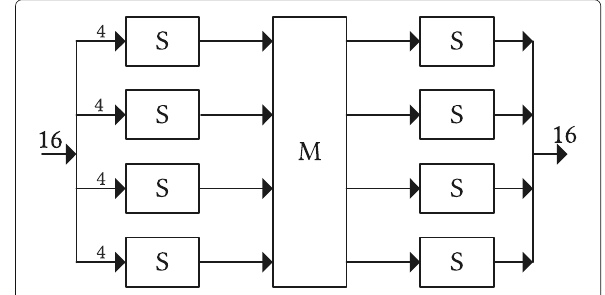
and X 2 ← X 2 ⊕ wk 3 . The function F consists of two S-box layers and a diffusion matrix M in which the 4- bit S-box is presented in Table 5. The diffusion matrix M is defined as M = The computation for the 16-bit data is defined as (